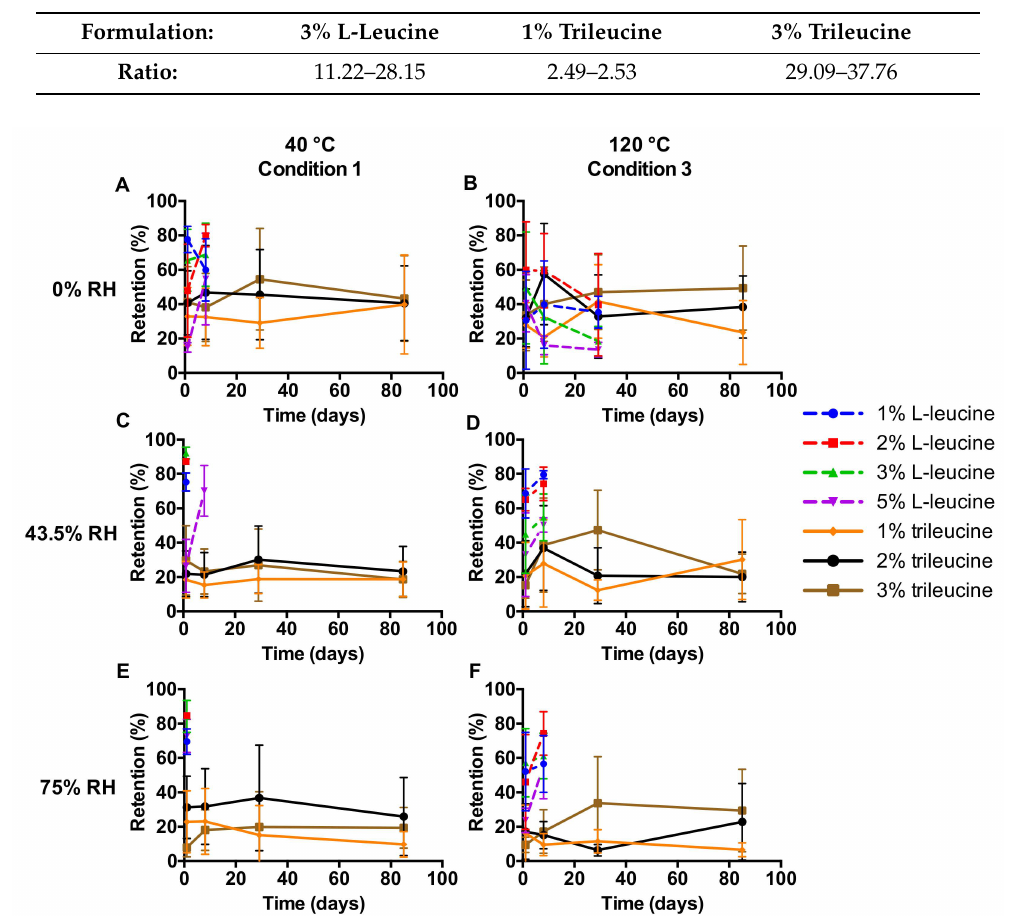
Table 2. The leucine / isoniazid surface ratios found during the TOF-SIMS analyses. The L-leucine formulation is spray-dried at 120 ◦ C, while the trileucine formulations are spray-dried at 40 ◦ C ( n = 2, both values shown).